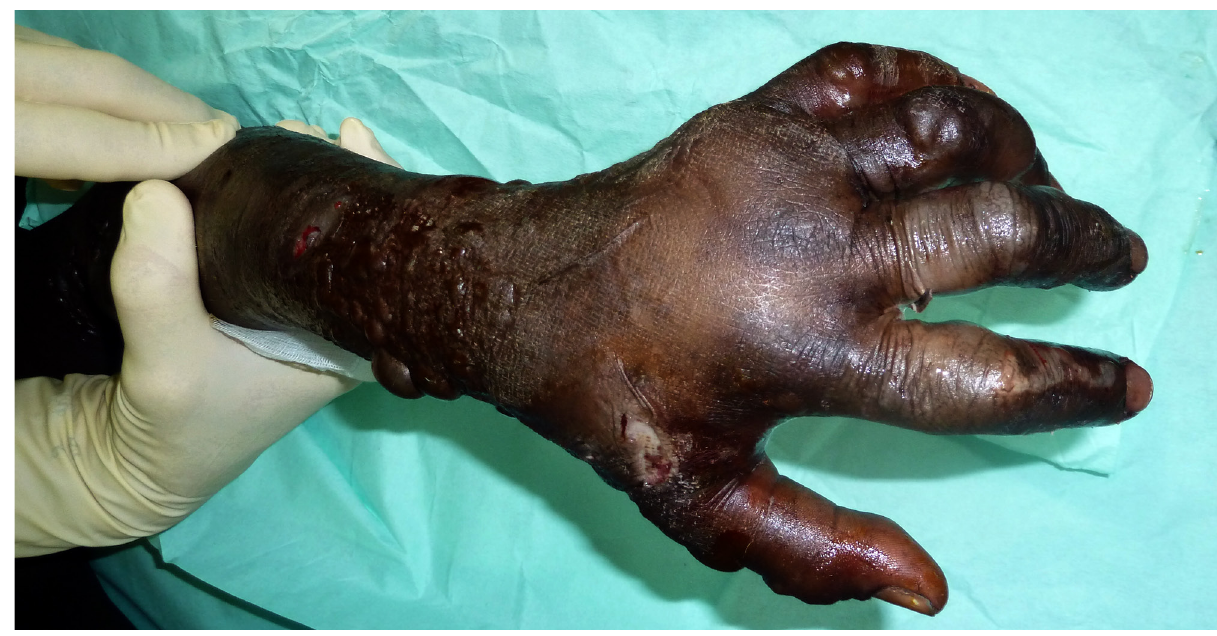
Figure 6. Initial aspect of the left hand.